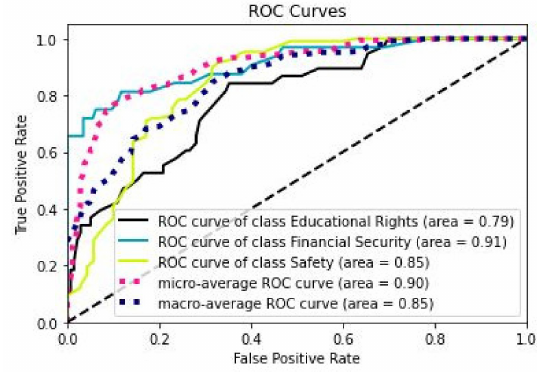
Figure 8. Random forest ROC—Aspect